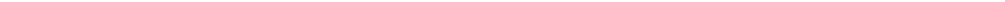
figure on next Fig. 5 A – F images: A 48‑year‑old female patient (BMI 35.7), dyslipidemic, non‑diabetic and non‑hypertensive, complaining of chest pain and = exertional dyspnea. Echocardiography revealed good systolic function (EF 66%), no regional wall motion abnormalities. A Two different views of = 3D volume rendered images, B Axial Maximum Intensity Projection (MIP) image, and C Sagittal curved planar reformatted image showing mildly ectatic proximal segment of LAD with anomalous origin of the RCA from mid‑LAD just opposite to D2 takeoff and right dominant circulation. Another small coronary artery arises from right coronary cusp supplying SA node branch and becomes very diminutive in caliber distally. D Axial curved planar reformatted image of LM and Ramus intermedius. E 3D volume rendered image and F 2D axial multiplanar reformatted image showing epicardial fat volume (212 cm 3